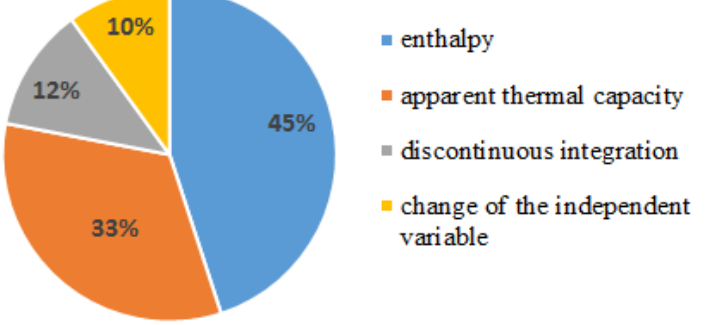
Figure 13. Different methods used in the thermal domain.